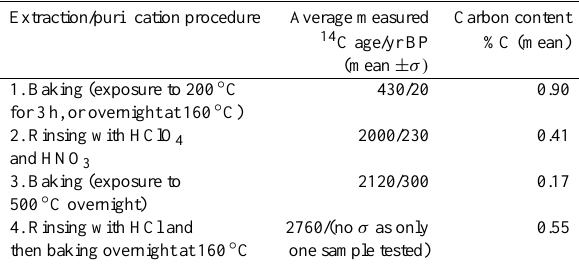
Table 1. Measured 14 C age of extracted Kandara soil phytolith con- centrate after exposure to additional purification steps (data from Santos et al.,